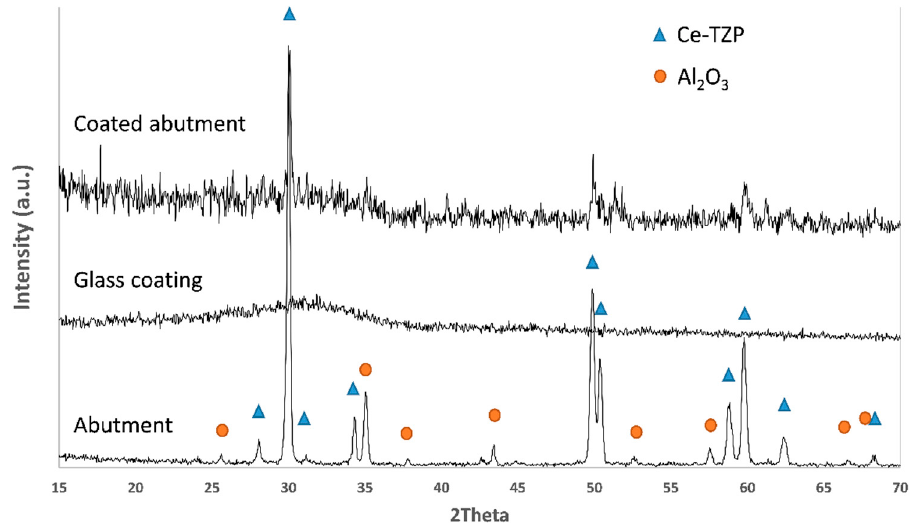
Figure 5. XRD pattern of the abutment, glass coating and glass-coated abutment. Continuous glass coatings with relatively homogeneous thicknesses (~35 µ m) along the cross section were obtained without delamination or cracks at the interface with the ceramic composite substrate (Figure 6A,B).